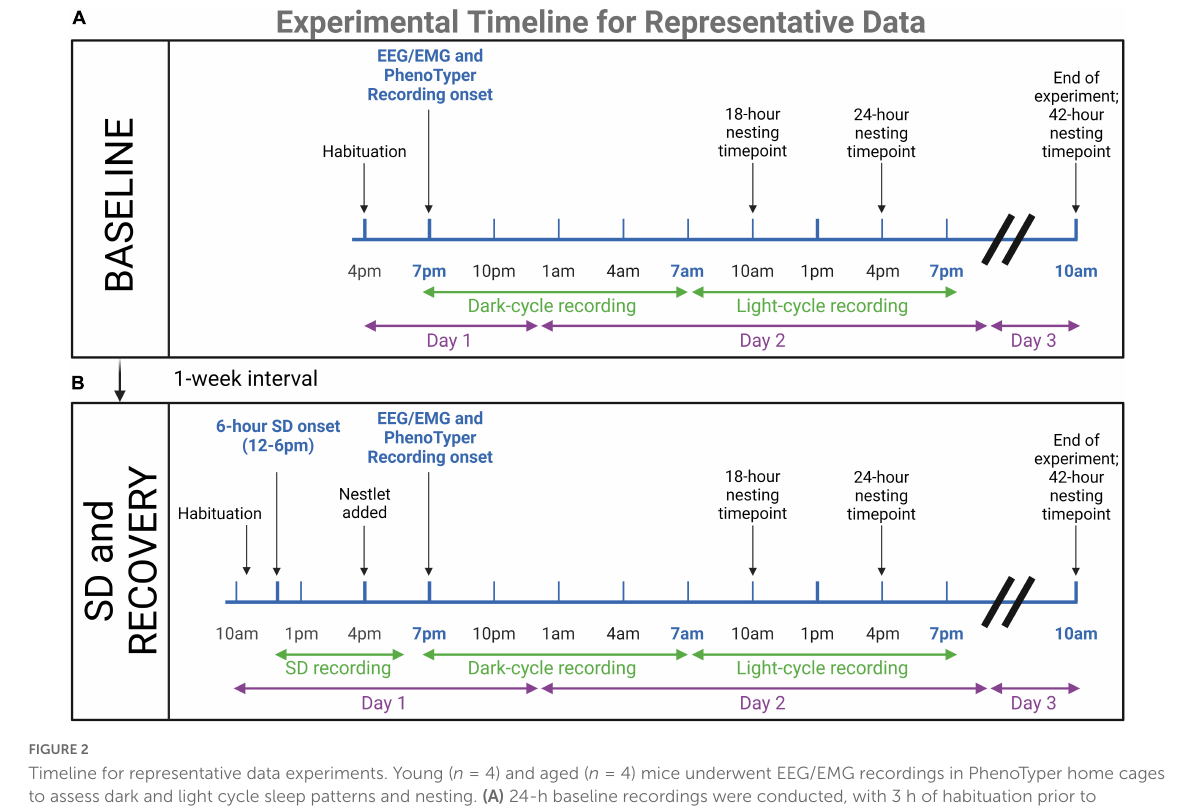
refer to Supplementary Figure 1 for representative stages